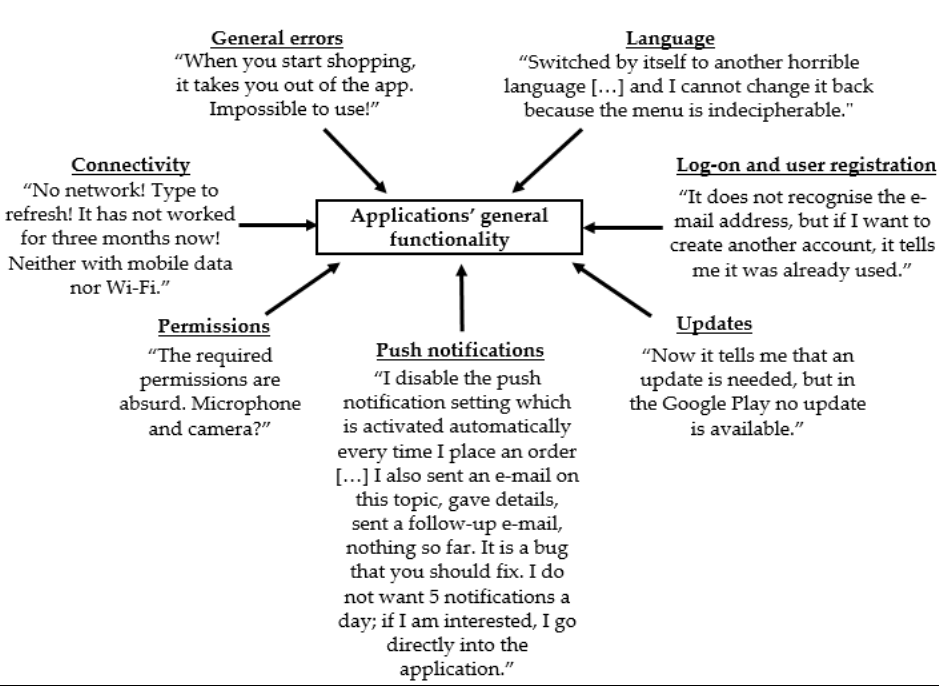
Figure 3. Examples of review comments focusing on general functionality challenges. Source: elaborated by the authors based on the data collected.